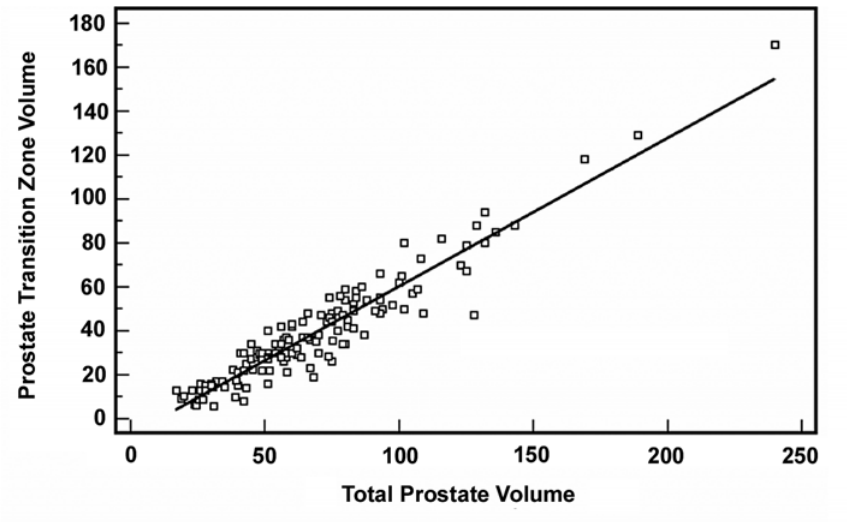
Figure 2 – Scatter graph with a regression straight line showing the correlation between the total prostate volume in cc and the vol- ume of the prostate transition zone in